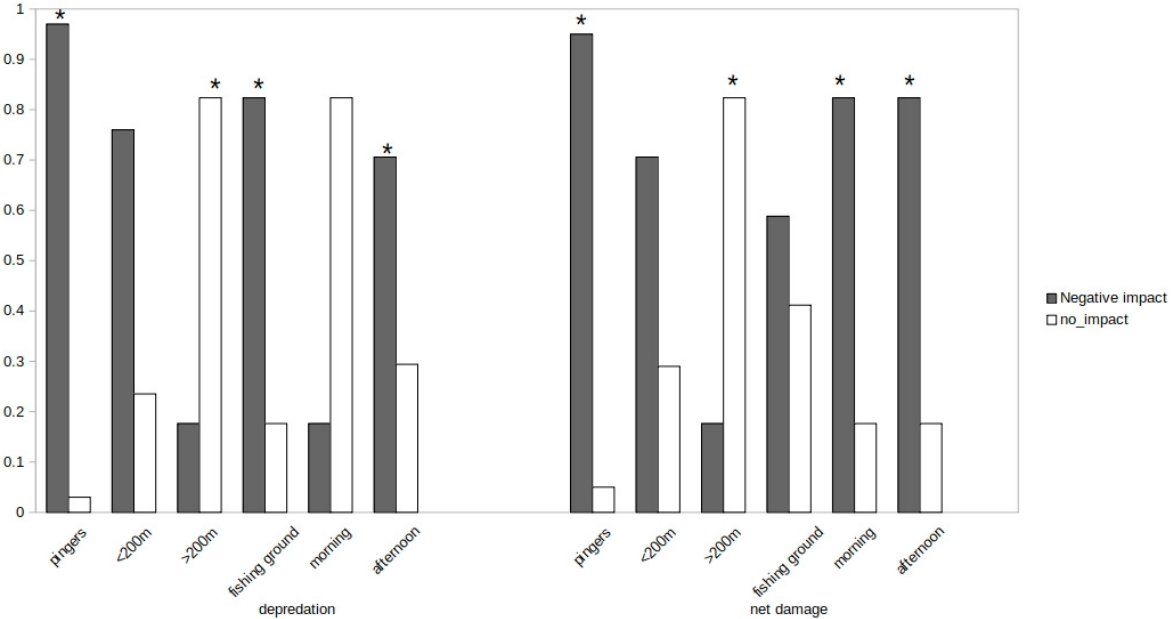
Figure 2. Frequencies on negative impact on fish depredation and net damage with respect to usage of acoustic pingers, depth, fishing ground, and time of the day of net soaking. Stars (*) denote significance level ( p < 0.05).